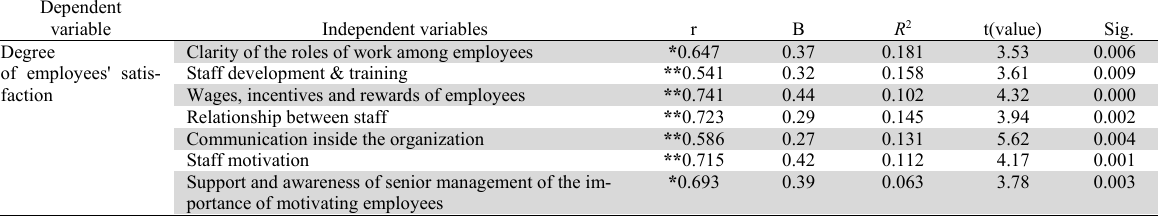
Results of correlation and regression analysis between study variables. Dependent variable Independent variables r B Sig. Degree Clarity of the roles of work among of employees' satis- faction